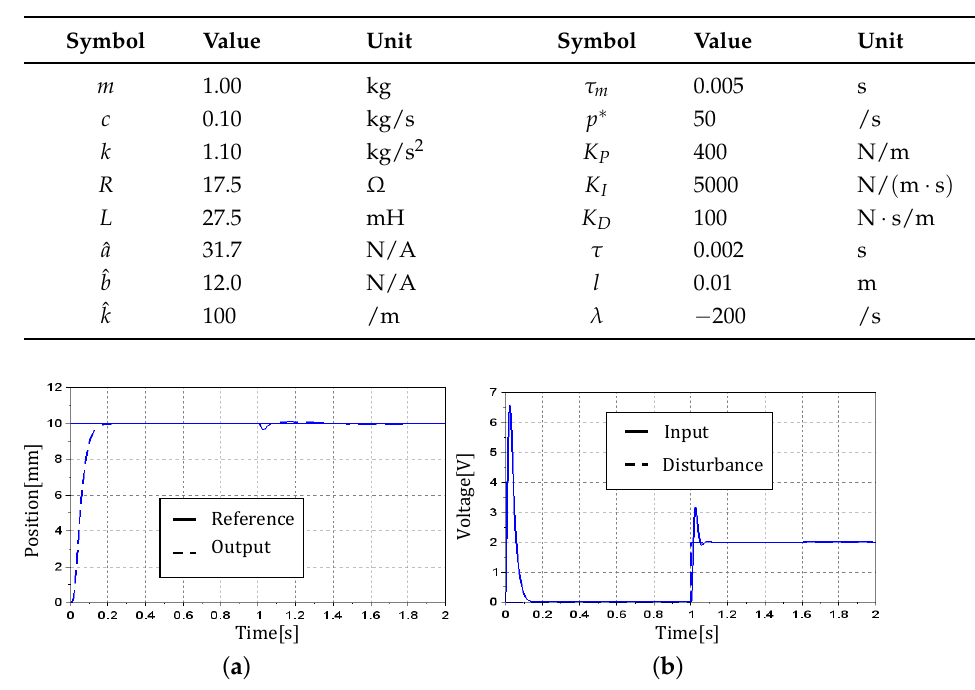
Table 2. Parameters for the simulation.